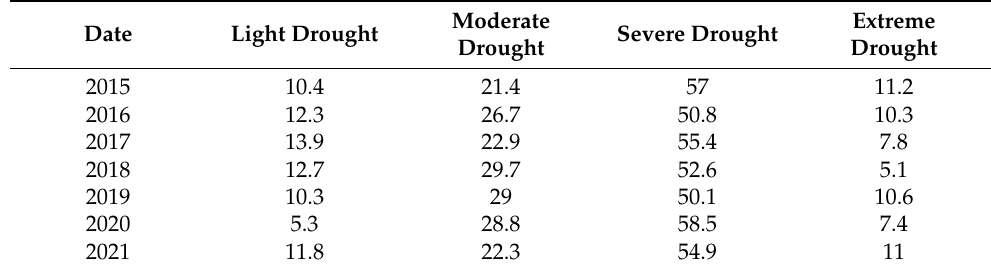
Table 3. Drought monitoring statistics of the mainstream of the Tarim River from 2015 to 2021 (unit: %).